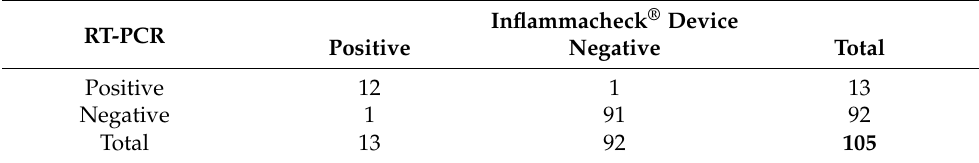
Table 2. Summary of the results of the Inflammacheck ® device compared to standard RT-PCR from nasopharyngeal swab